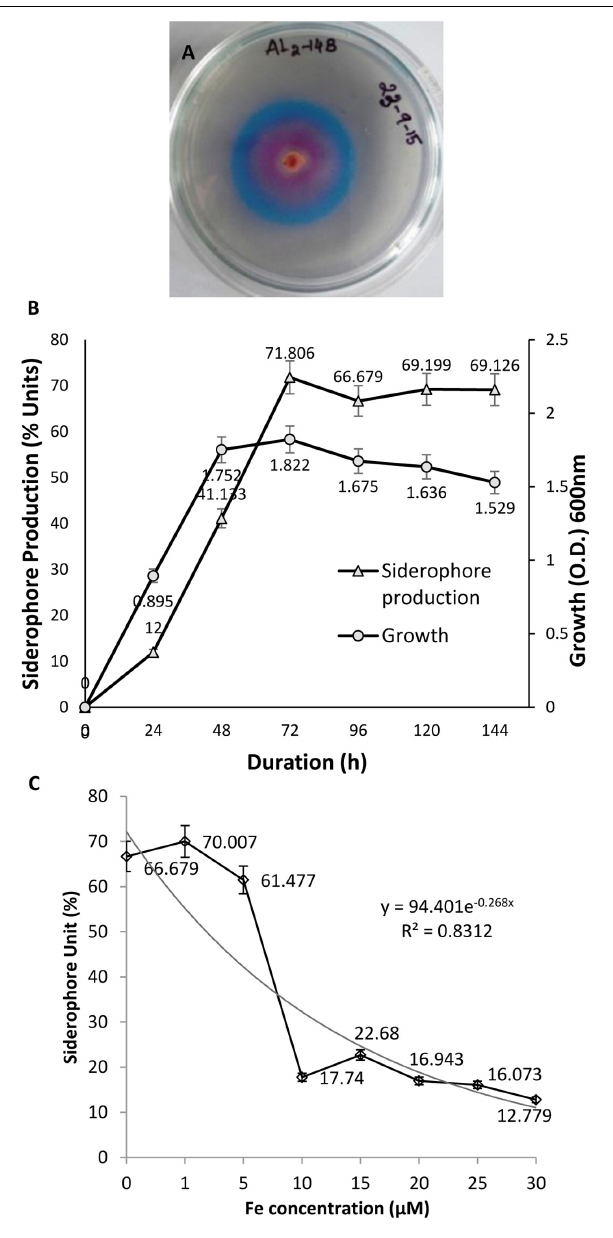
FIGURE 2 | Pseudomonas aeruginosa AL2-14B. (A) Siderophore release and formation of halozone in CAS agar medium; (B) quantitative estimation of siderophore release against growth of bacteria; (C) effect of iron on siderophore production.